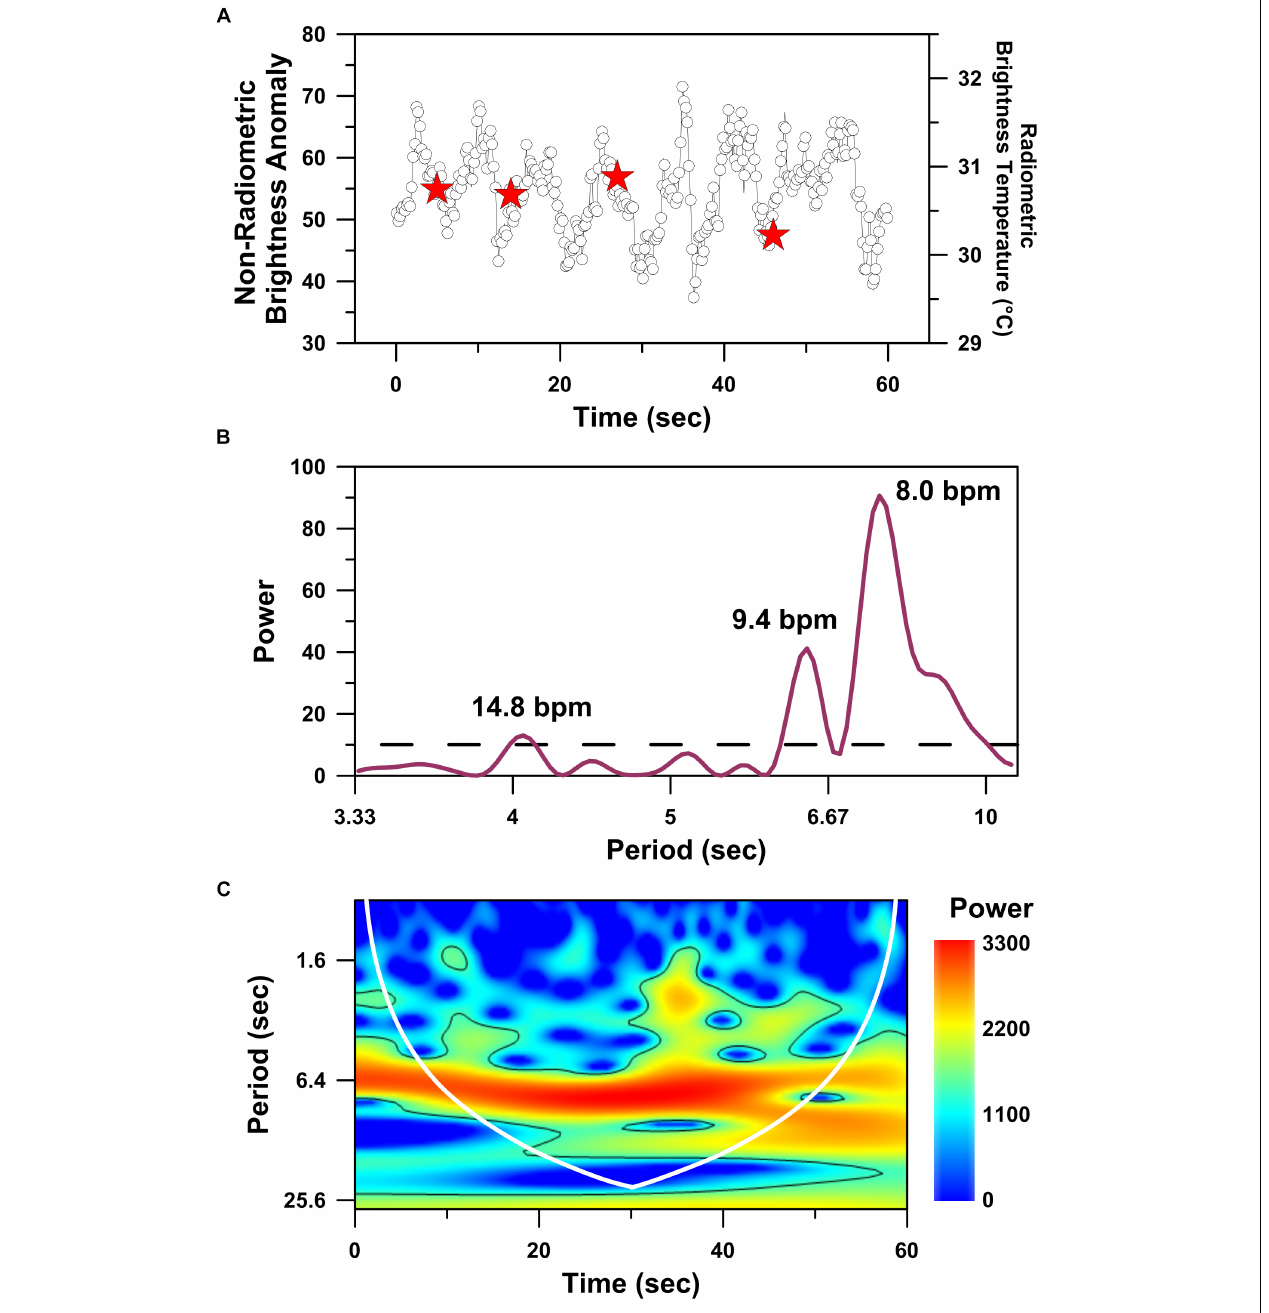
FIGURE 4 | Time series analyses performed on the hottest infrared hot-spot recognized in drone-deployed non-radiometric thermographic video of a mother humpback whale’s dorsal fin. Time series plot of non-radiometric dorsal fin hot-spot intensities (white circles) and radiometric dorsal fin hot-spot temperatures (red stars) simultaneously recorded over a 60 s interval (A) . Periodogram showing significant ( p < 0.05) periodicities (above dashed line) present in the dorsal fin hot-spot time series dataset and detected using the Lomb–Scargle algorithm (B) . Wavelet power spectrum showing significant ( p < 0.05) periodicities (i.e., higher power areas inside the solid black line) present in the dorsal fin hot-spot time series dataset (C) . Cone of influence indicated by white line in C